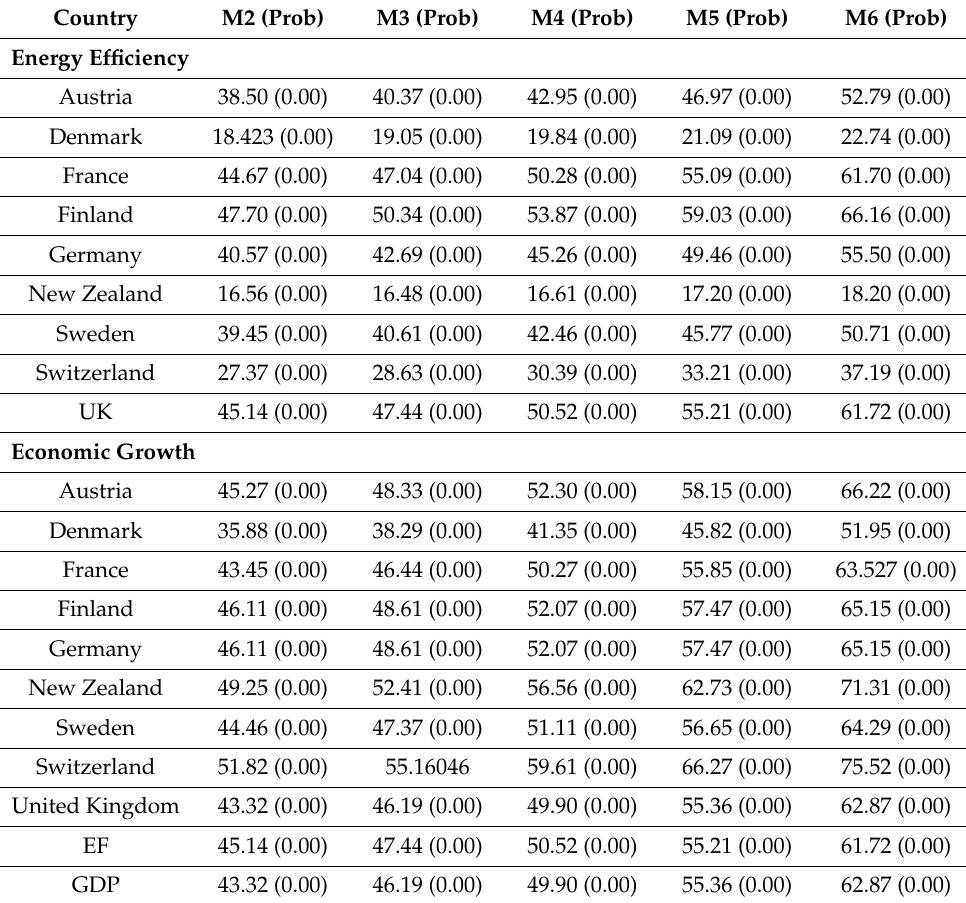
Table 2. Results of the BDS test for